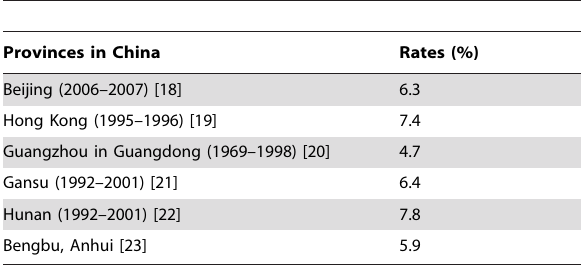
Table 3. Rates of preterm labour or delivery ( , 37 weeks gestation) by provinces in China.